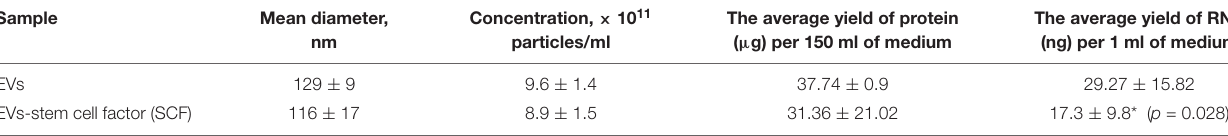
TABLE 1 | Quantitative characterization of extracellular vesicles (EVs). Sample The average yield of protein